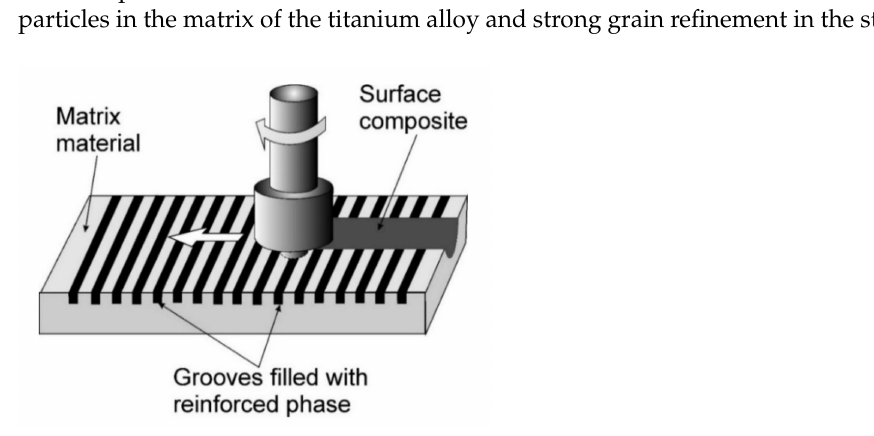
Figure 2. Diagram of groove method with grooves located transversely to direction of tool travel (authors’ own